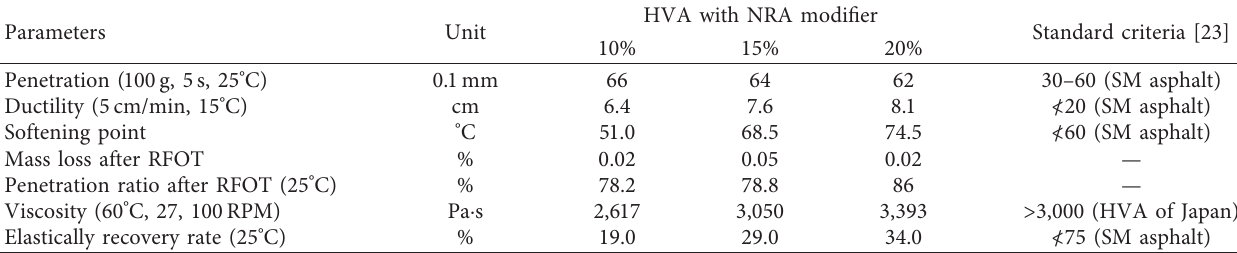
Table 3: Performance of high viscosity asphalt binder.